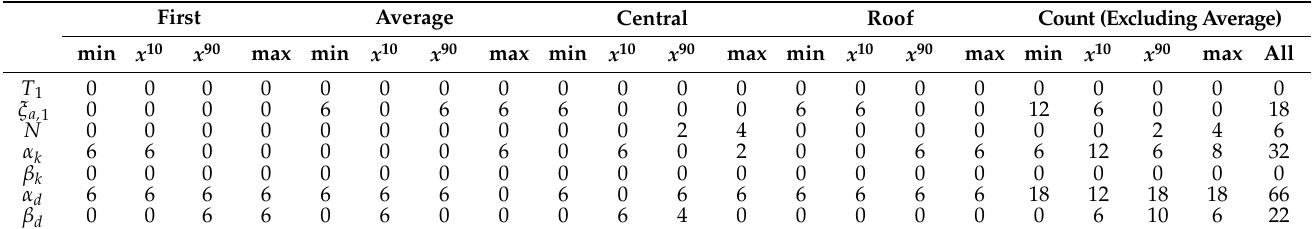
Table 5. Relevance of parameters for ∆ 1,error and shear-type frames (B0- ∞ , B3- ∞ , B5- ∞ , C0- ∞ , C3- ∞ , C5- ∞